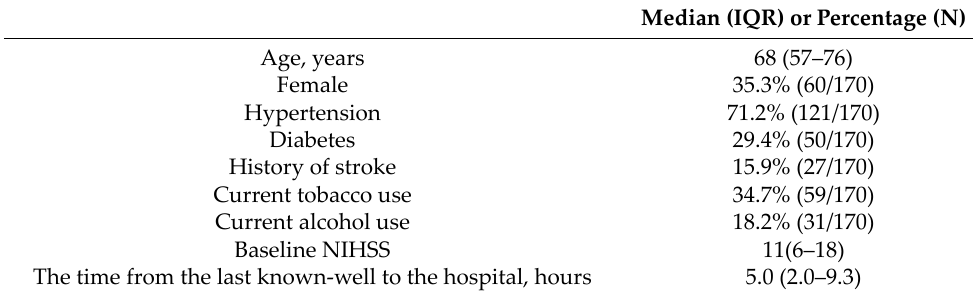
Table 1. Demographic characteristics, treatments, and outcomes of the included